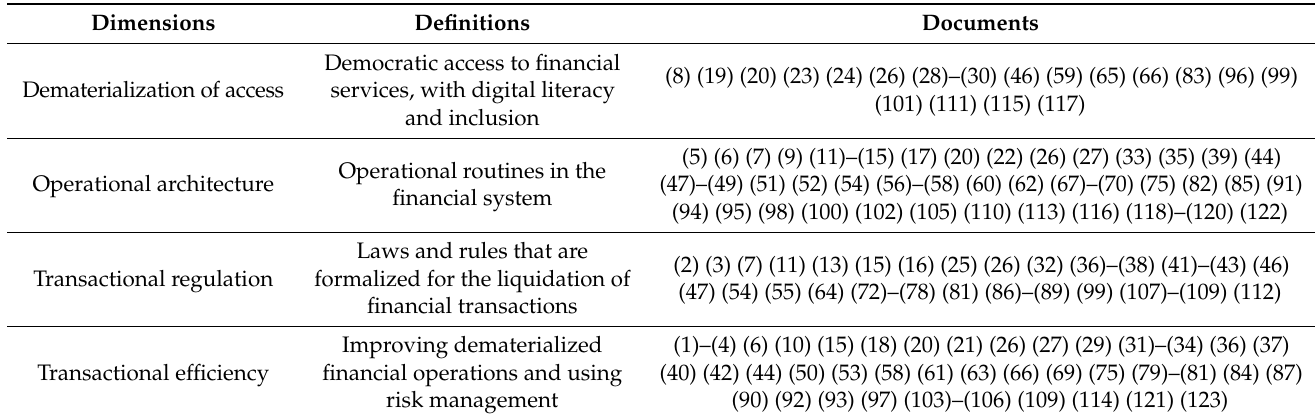
Table 3. A summary of the dimensions and the systematic literature